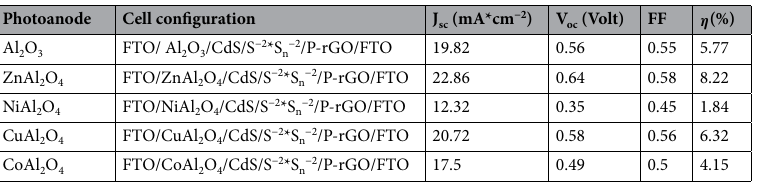
Table 3. Photovoltaic parameter of Al 2 O 3 NP s and MAl 2 O 4 with 6 cycles CdS QD s as a photosensitizer with P-rGO as a counter electrode.